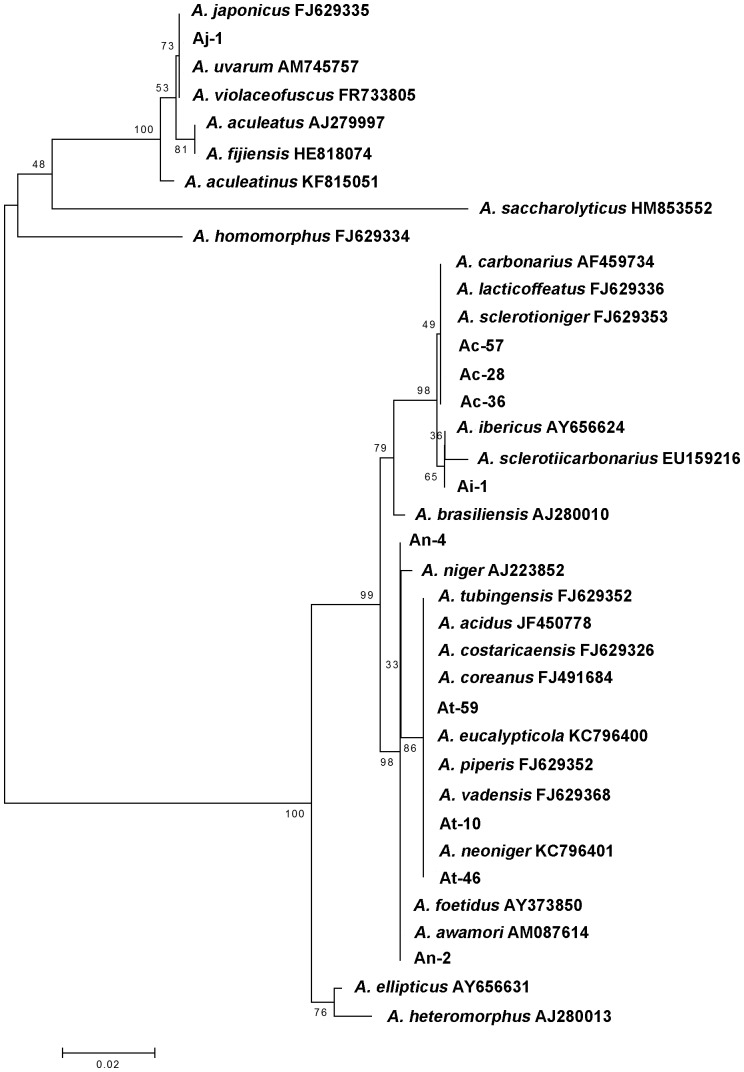
Neighbour-Joining phylogenetic tree based on divergences of ribosomal 5.8S-ITS sequences.The alignment of ribosomal 5.8S-ITS sequences from 10 isolates and 10 reference strains of Aspergillus spp. was performed using the CLUSTALΩ program. Nucleotide divergences were estimated according to the Jukes–Cantor model. Node numbers represent the frequency (proportion) with which a cluster appears in 1000 bootstrap runs.